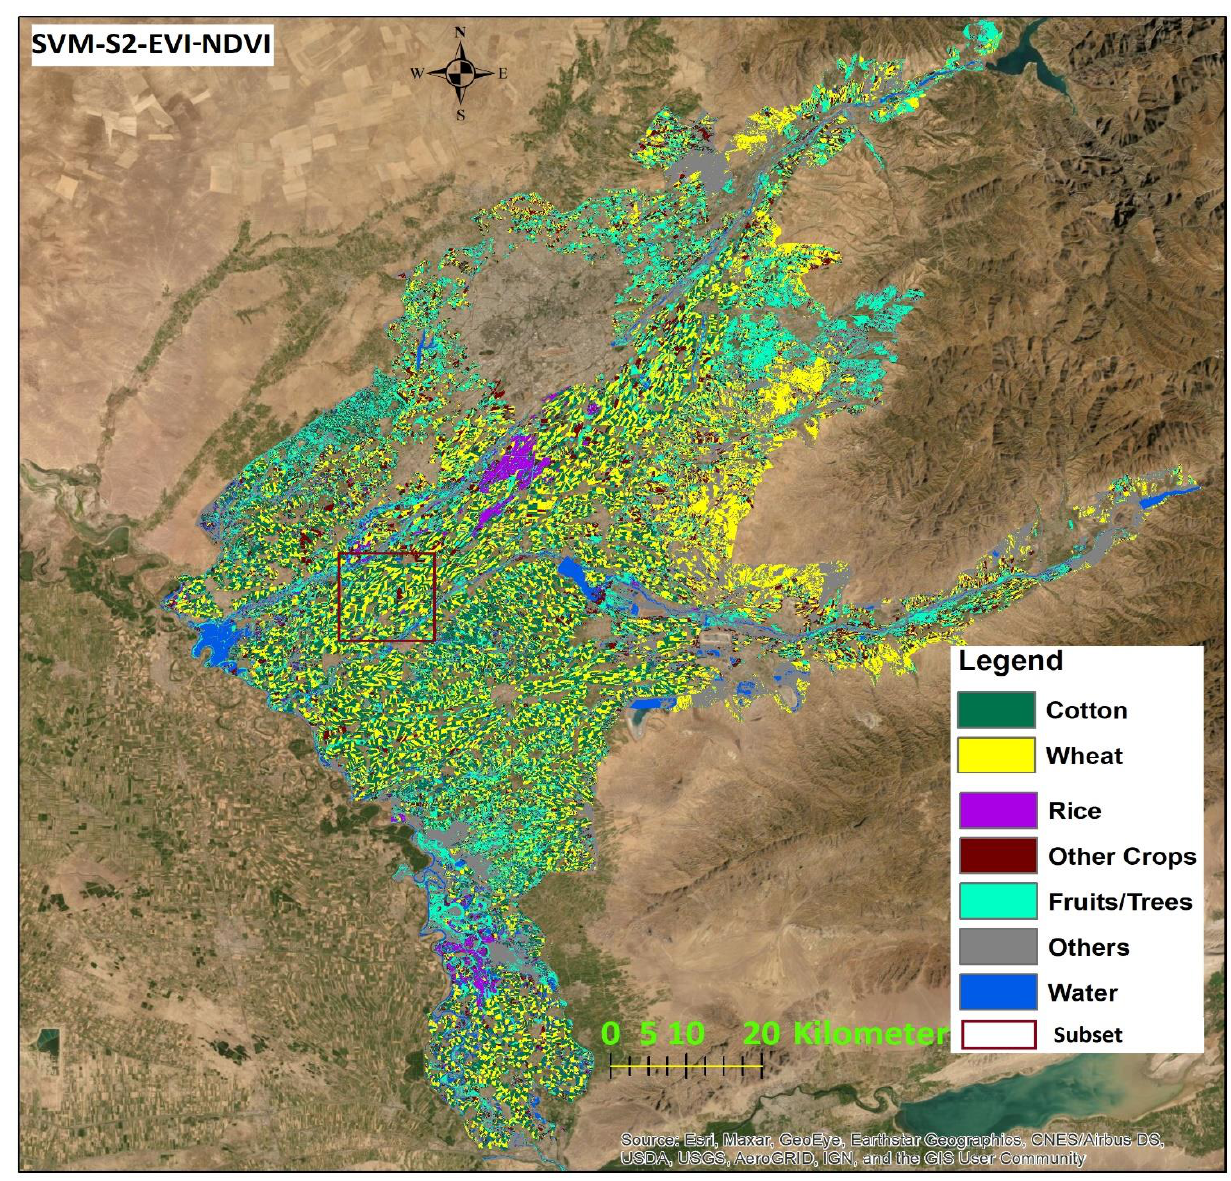
Figure 12. Classification result of S2-SVM-EVI-NDVI (highest OA 88% for SVM).